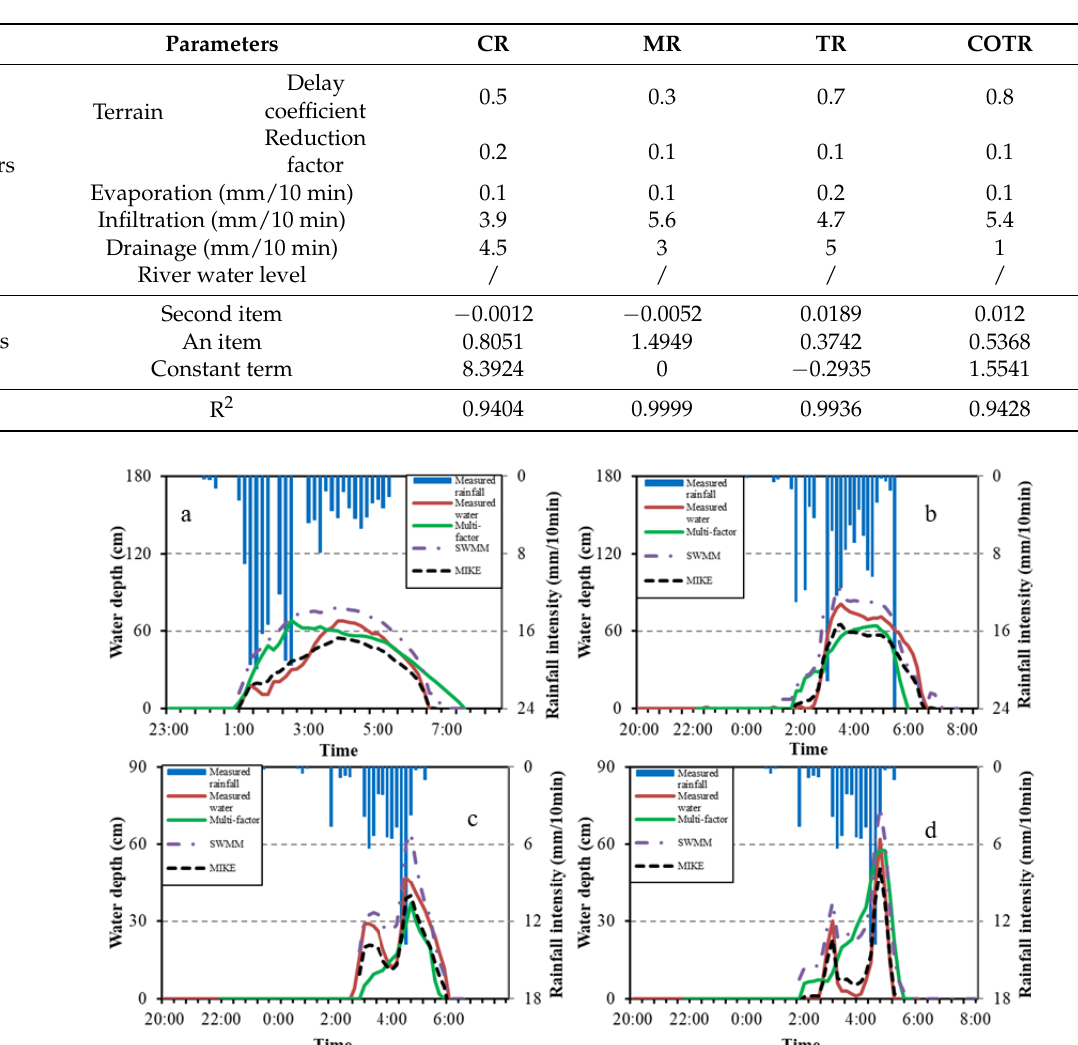
Table 5. Multi-factor Correlation Model parameters of the four selected flooding point.